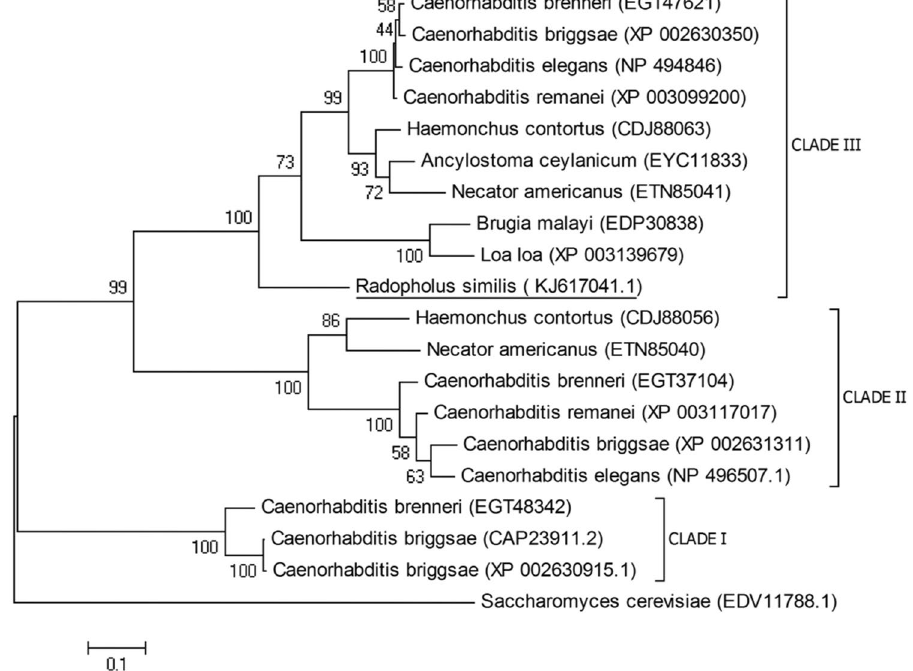
Figure 3. Maximum-likelihood phylogenetic tree containing 20 SCPs. A tree constructed with 20 SCPs from 10 species of nematodes and Saccharomyces cerevisiae was generated using MEGA 5. Radopholus similis SCP is underlined. Sequence accession numbers are shown in